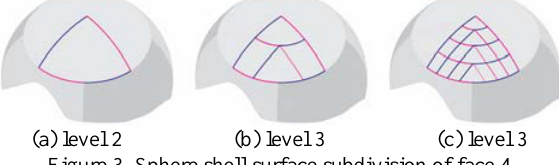
Figure 3. Sphere shell surface subdivision of face 4